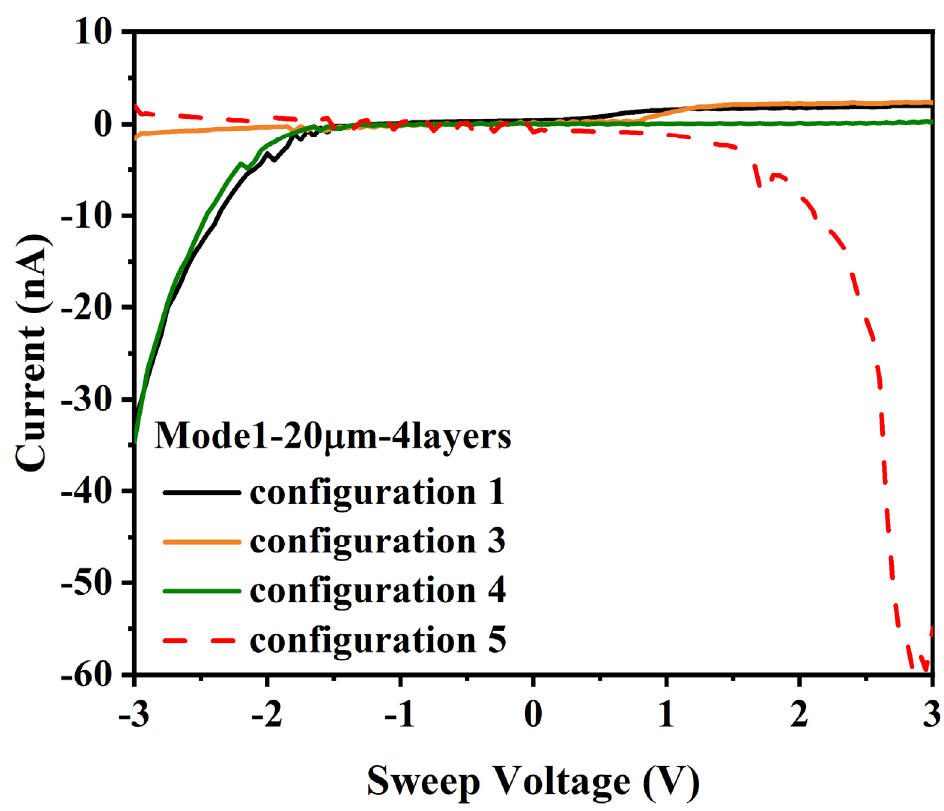
Figure 8. I/V curves for 20 µm gap, 4 layers, and voltage applied to: ( a ) (configuration 1) A1, B1–B3 grounded; ( b ) (configuration 3) A1, B2 grounded, B1, B3 float; ( c ) (configuration 4) A1, B3 grounded, B1, B2 float; ( d ) (configuration 5) B1–B3, A1 grounded.